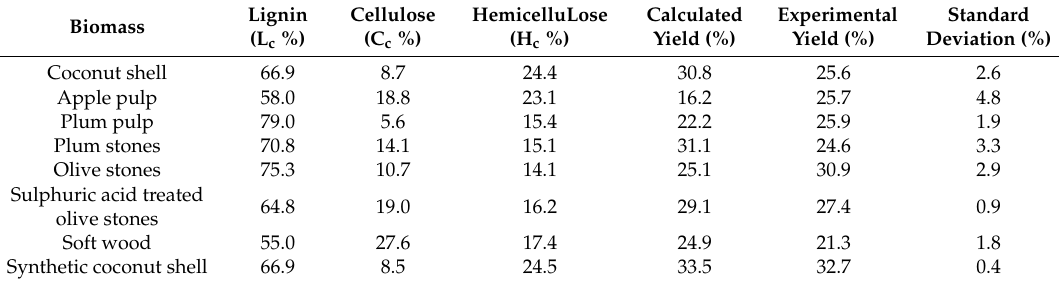
Table 3. The weight contributions of lignin, cellulose and hemicellulose to the carbon yields of different biomass